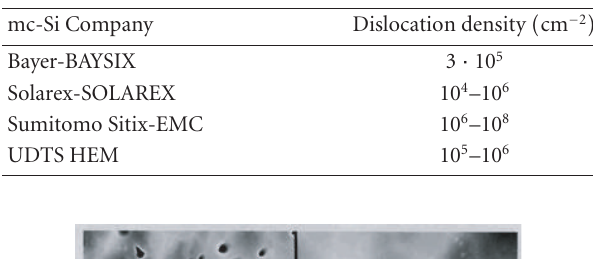
Table 2: Comparative study of dislocation density values from other mc-Si producers.